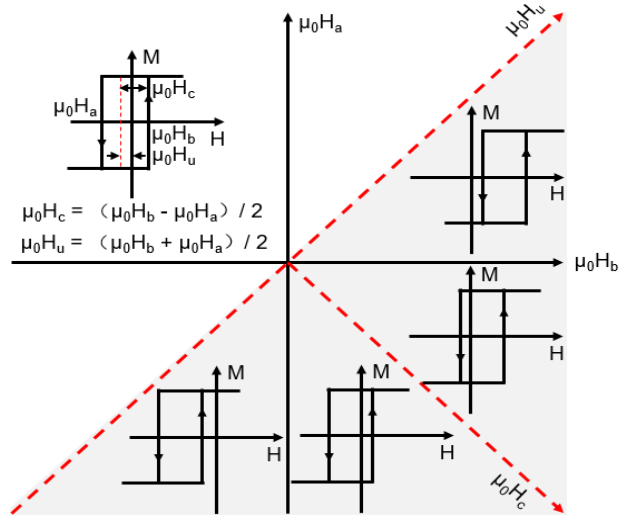
Figure 3. Coordinate composed of μ 0 H a and μ 0 H b or μ 0 H c and μ 0 H u .